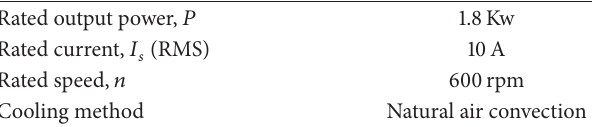
Table 1: Machine design